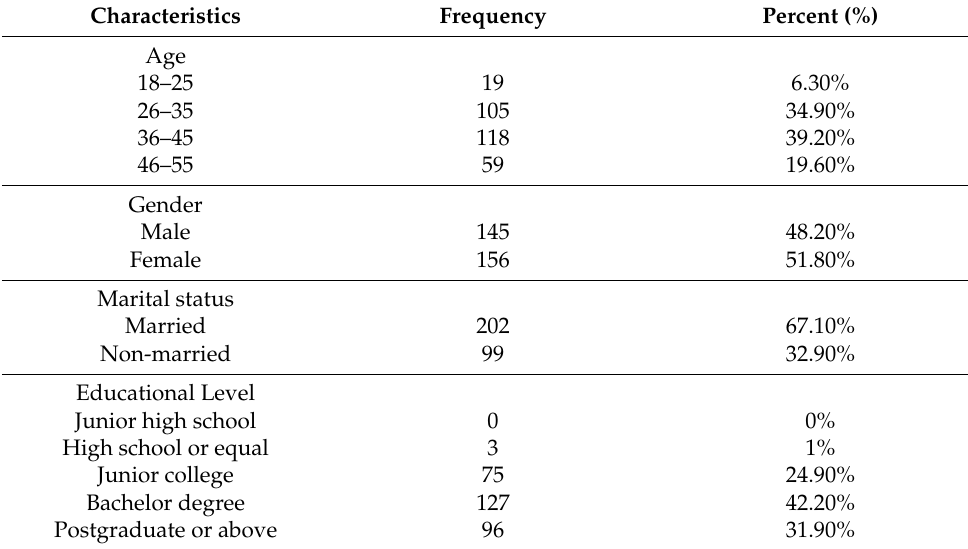
Table 1. Sample demographics.